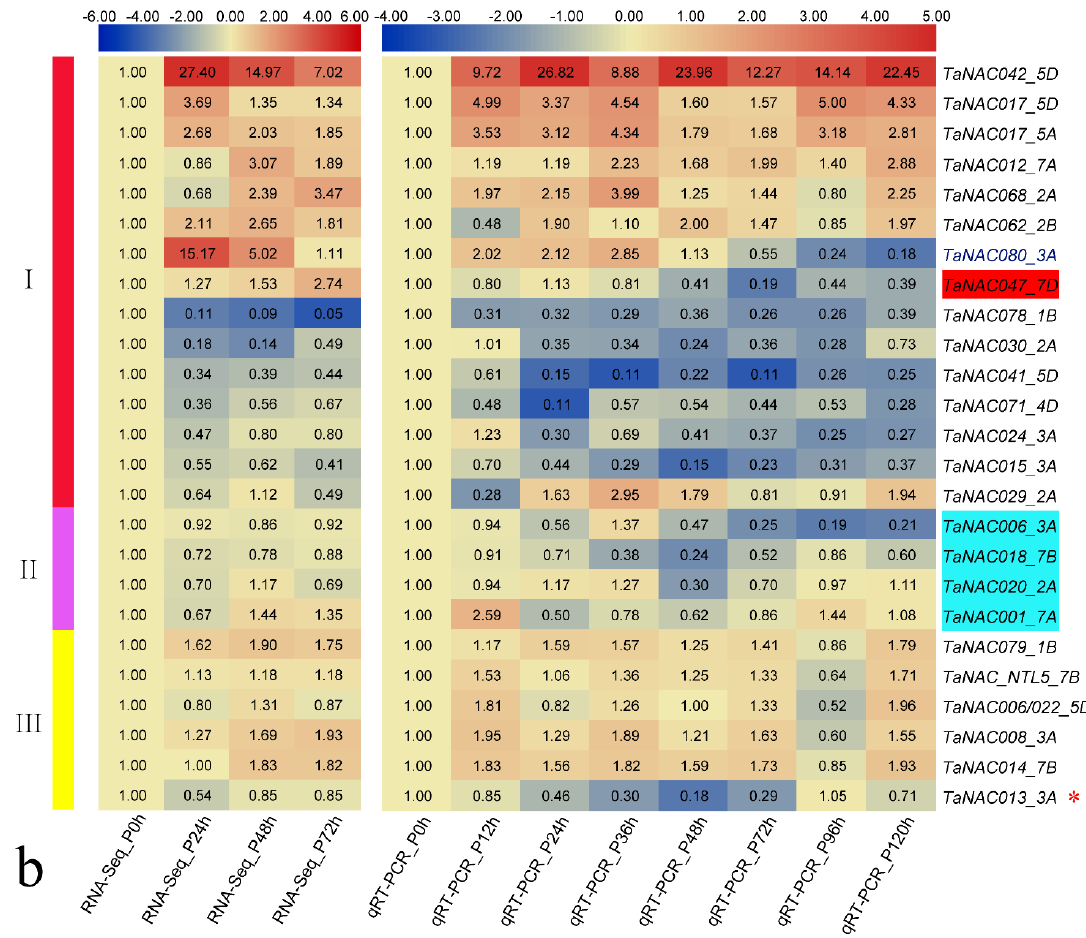
Figure 2. Expression heat map of 25 selected TaNAC genes under stress due to stripe rust or powdery mildew. ( a ) Pst treatment; ( b ) Bgt treatment. (left) Expression determined by RNA-seq, and values represent fold change of average reads per kilobase of transcript per million mapped (RPKM) across three replicate samples; (right) expression of corresponding TaNAC genes according to qRT-PCR, and value is relative expression calculated using 2 −ΔΔ Ct . S: stripe-rust stress; P: powdery-mildew stress; 0, 24 h, etc.: time interval between sampling and inoculation. Group I contained genes that were differentially expressed under both Pst and Bgt stress. ( a ) Group II contained genes that were non-DE